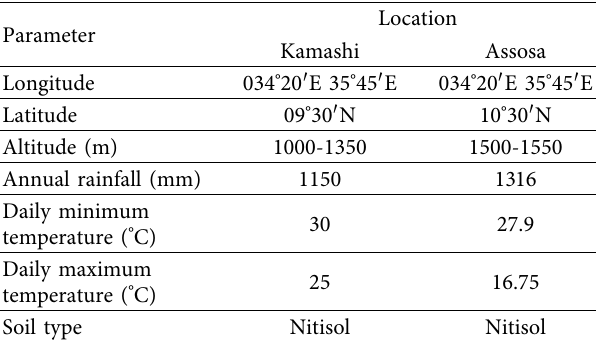
Table 1: Descriptions of the test environments for geographical